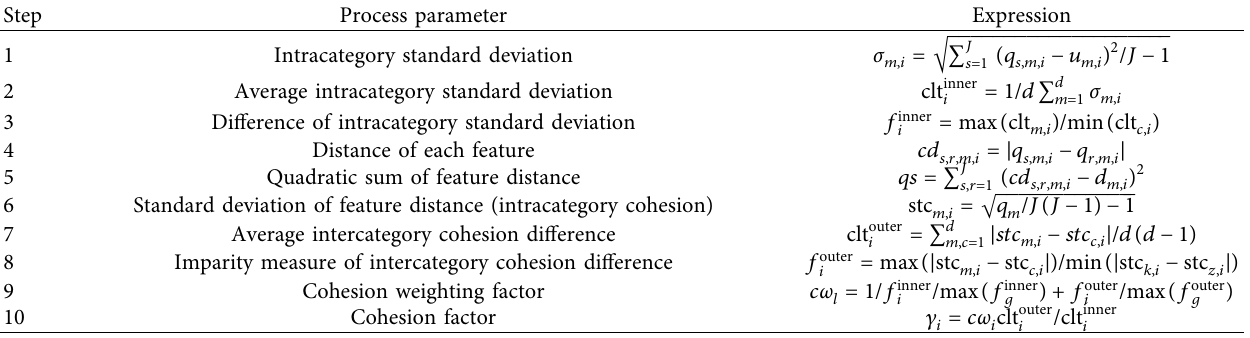
Table 1: Cohesion evaluation.